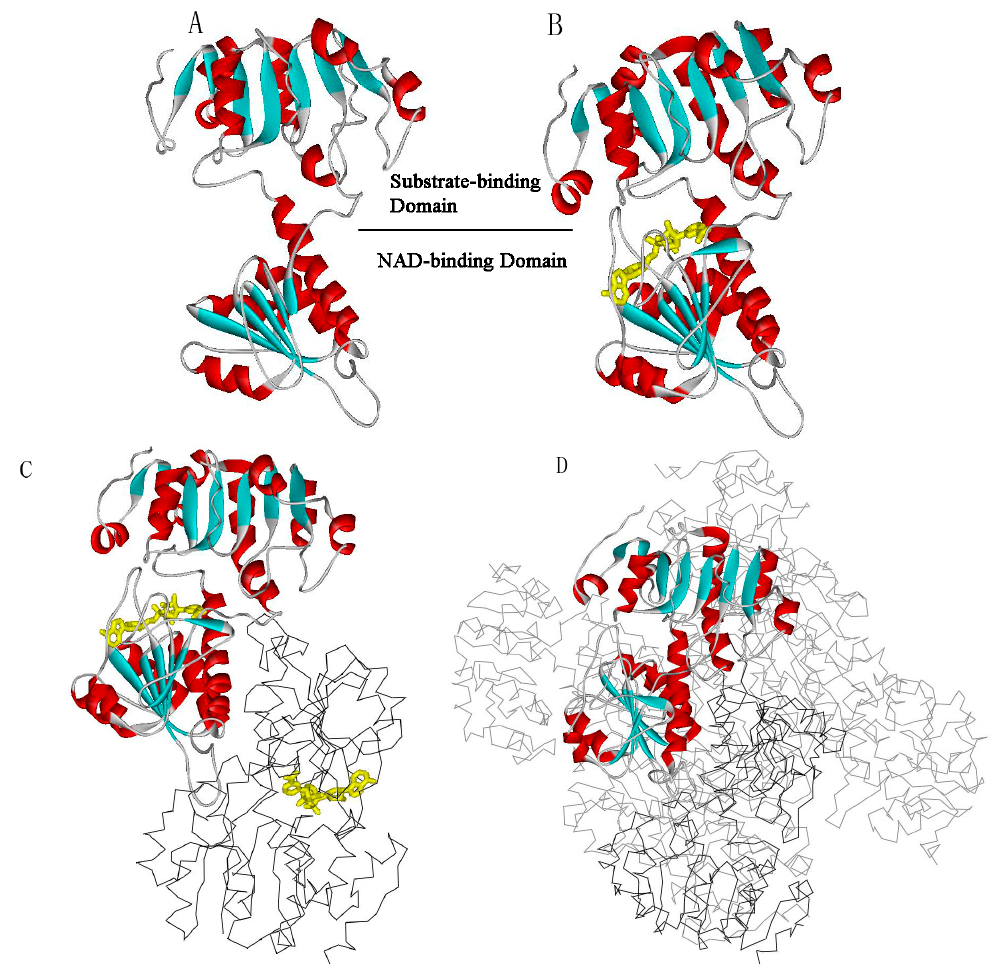
Figure 1. Open-apo (one monomer of 2VOE) ( A ) and closed-holo (one monomer of 2VHZ) ( B ) structures of L - Mt AlaDH. The bound ligand is shown as a yellow ball-and-stick model in the closed-holo structure. The secondary substructures α -helices and β -sheets of the protein are displayed in red and blue colors, respectively. The protein is divided into the substrate-binding domain and the 1,4-dihydronicotinamide adenine dinucleotide (NAD)-binding domain, which is marked in the structure; ( C ) The dimeric L - Mt AlaDH molecule. One monomer is shown in the solid ribbon model, and the other is shown in gray; ( D ) The hexameric L - Mt AlaDH molecule. One monomer is shown in the solid ribbon model, and others are shown in gray.